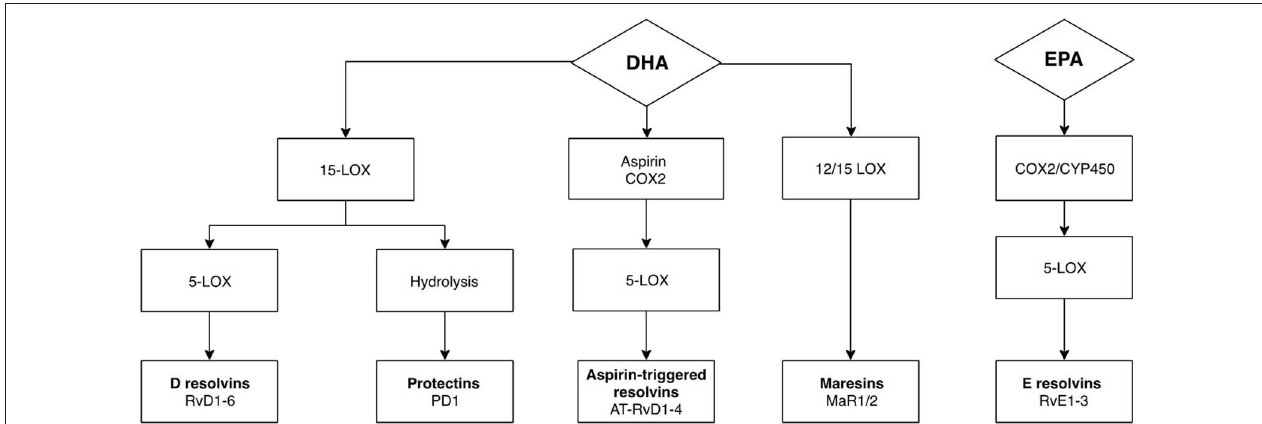
FIGURE 1 | Metabolism of DHA and EPA to SPMs through enzymatic transformation. SPMs are produced upon metabolism of n-3 PUFAs by specific lipoxygenase and cyclooxygenase enzymes. Respectively, the enzymes 15-lipoxygenase-1 (15-LOX) and 12-lipoxygenase (12-LOX) are responsible for initiating the conversion of DHA to protectin-1 (PD1), and maresin 1 and 2 (MaR1, MaR2), whereas 15-LOX, cyclooxygenase 2 (COX-2) and cytochrome P450 are responsible for the conversion of DHA to resolvins D series (RvD), and of EPA to resolvins E series (RvE). Downstream, metabolism of RvD and RvE are dependent on 5-lipoxygenase (5-LOX). Aspirin-acetylated COX-2 followed by 5-lipoxygenase (5-LOX) transformation generates aspirin-triggered isomers of RvDs